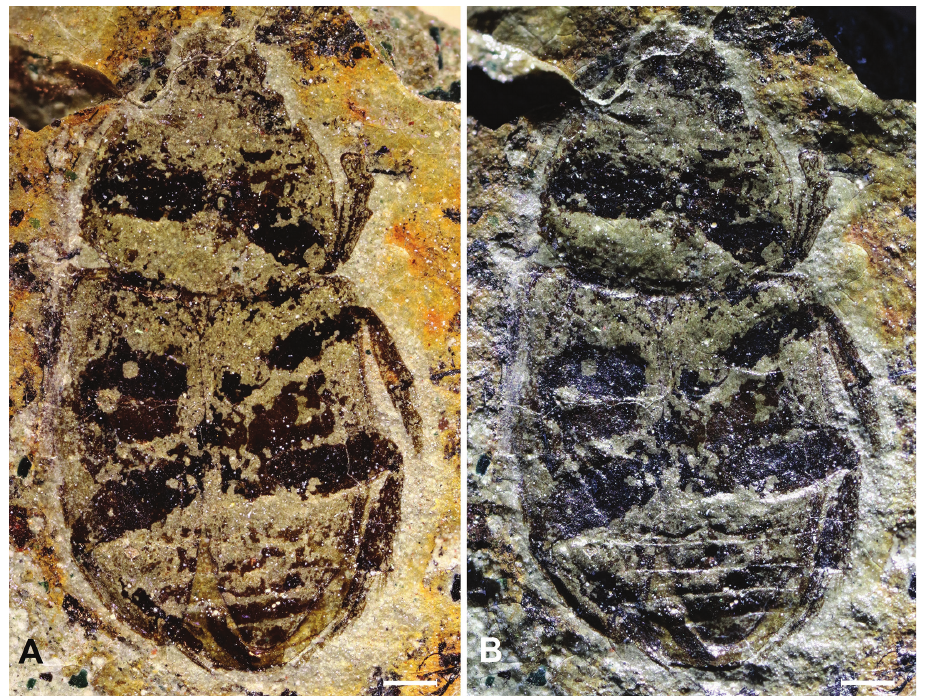
Figure 3. Ceafornotensis archratiras gen. and sp. n.: holotype BP/2/18654, general appearance. Micro- graphs taken under: A polarised light B low angle unpolarised light. Scale bar: 1 mm.